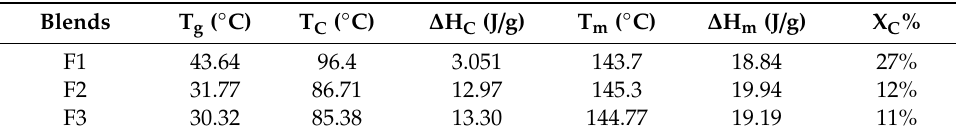
Table 6. Results of differential scanning calorimetry (DSC) analysis (first heating).